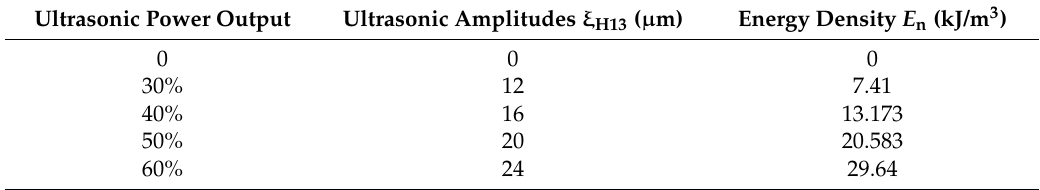
Table 4. The ultrasonic energy densities and amplitudes at different ultrasonic power